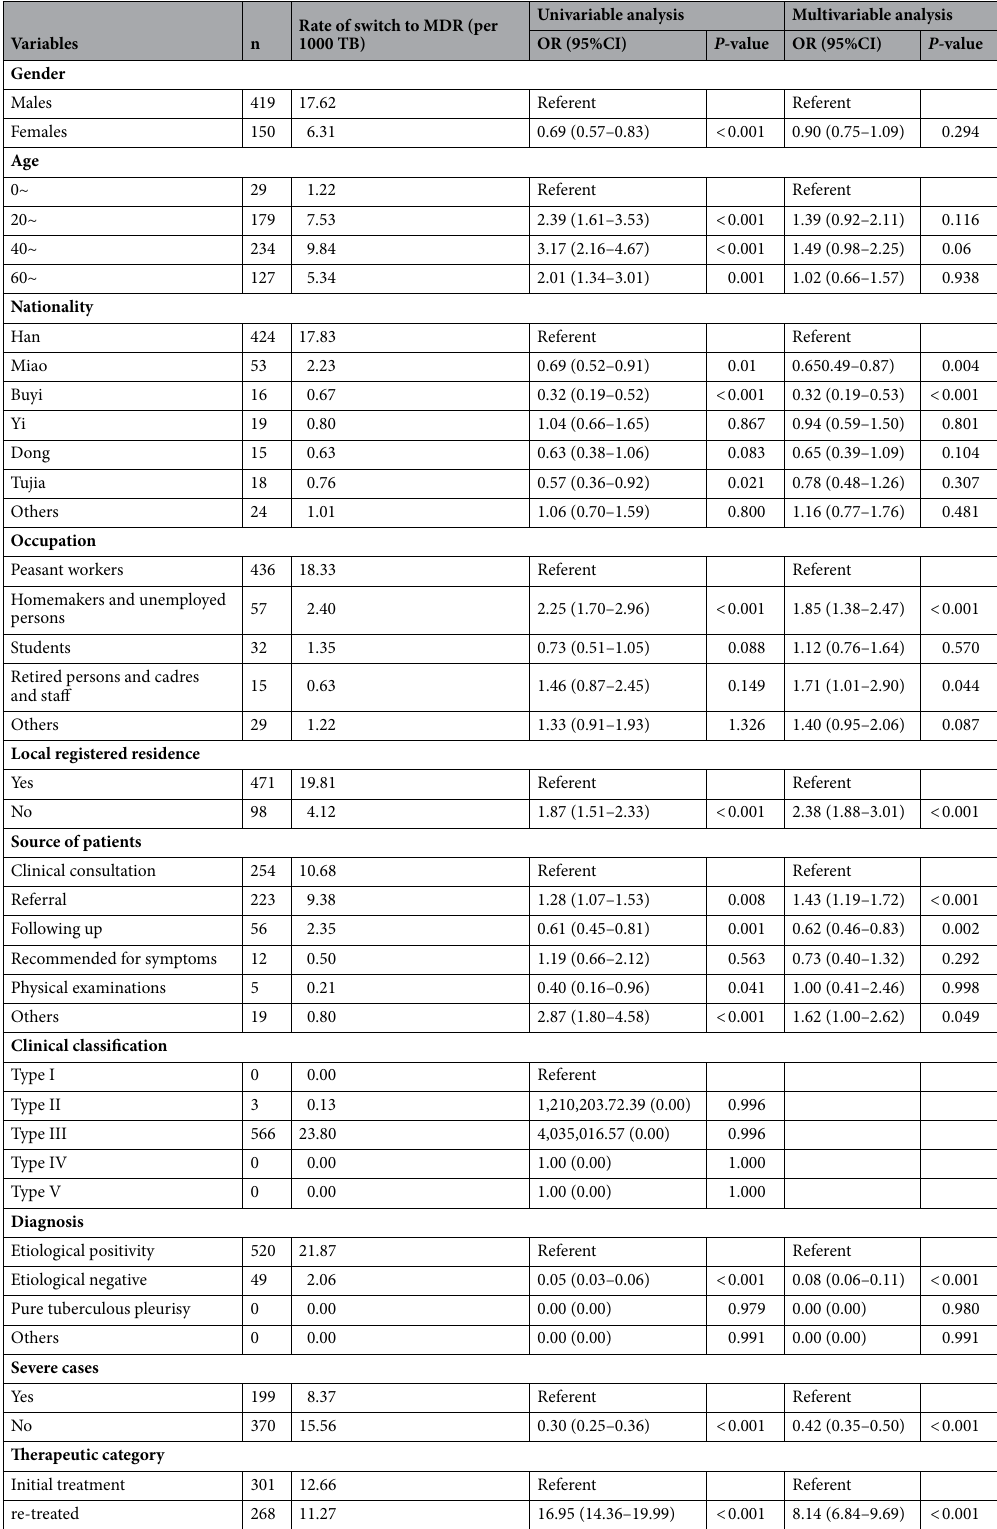
Table 5. Results of risk factors analysis of switch to MDR in TB